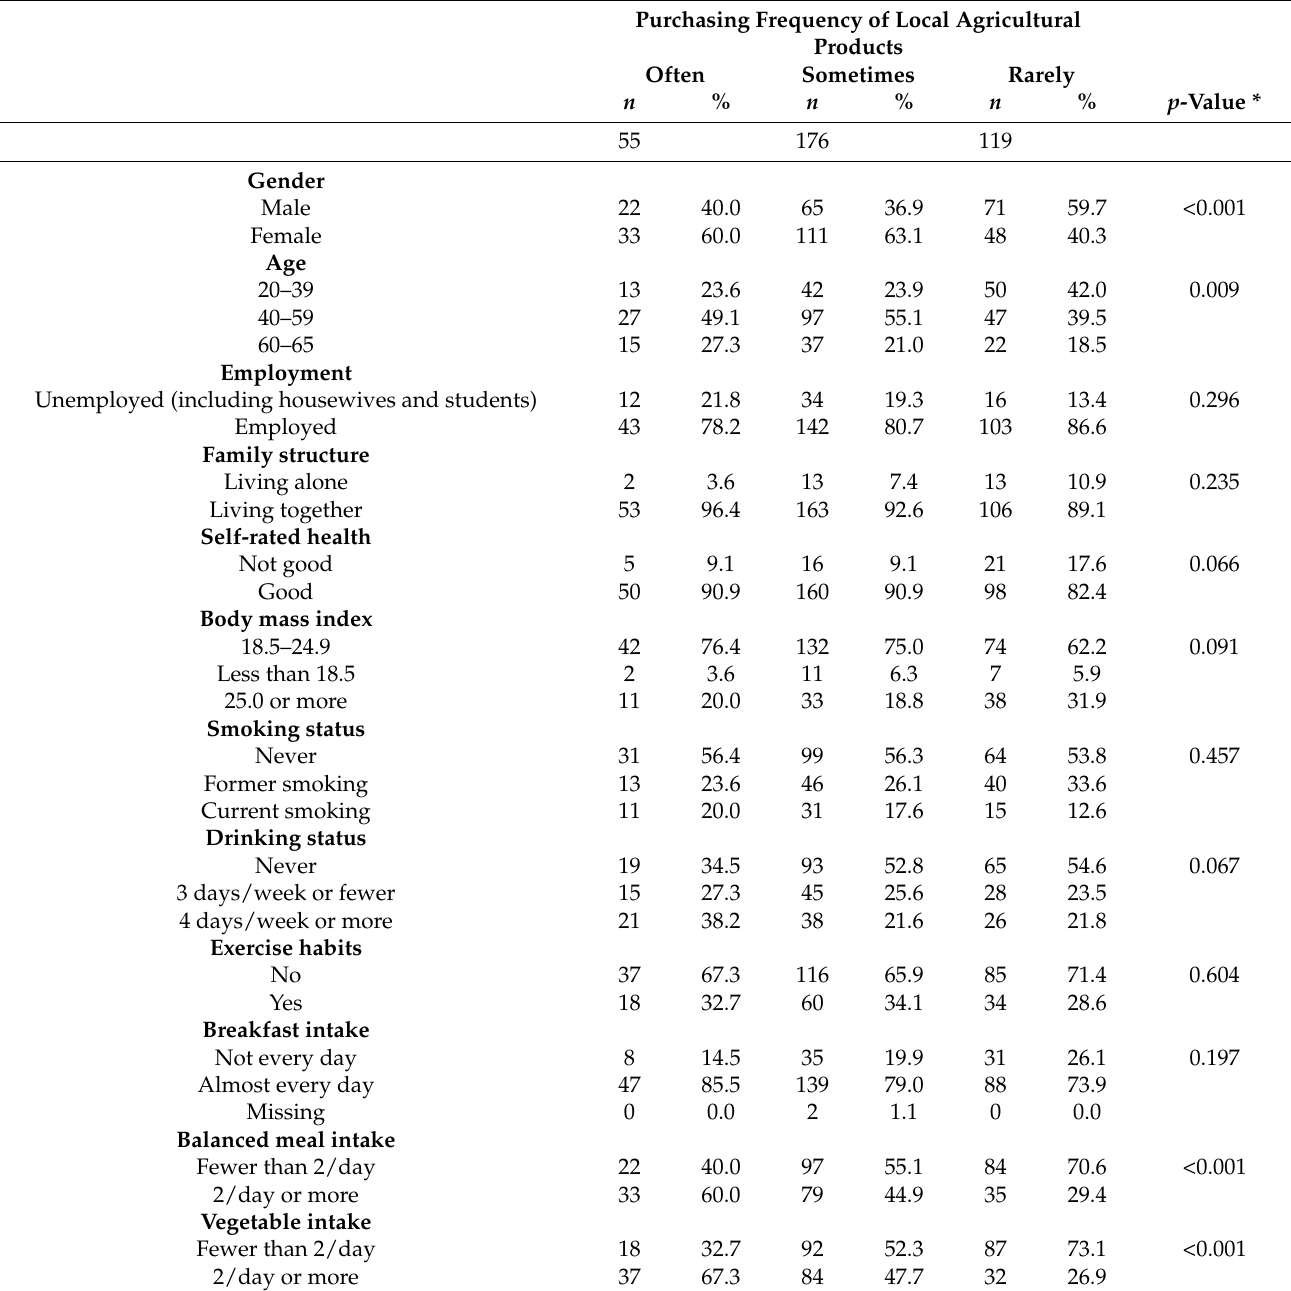
Table 1. Distribution of responses according to the purchasing frequency of local agricultural products (n =